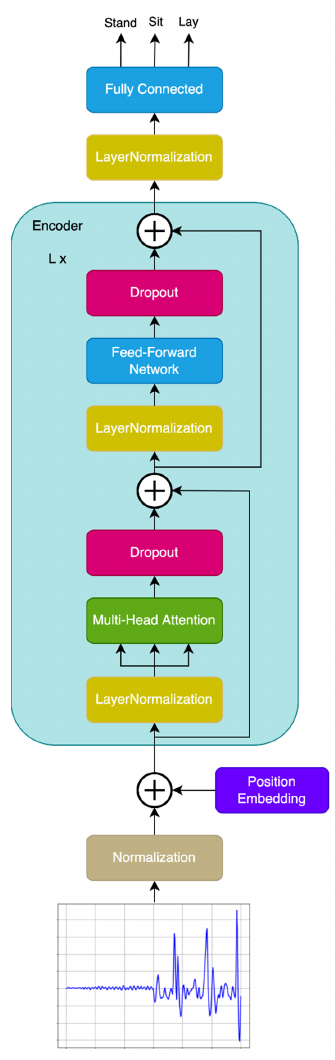
Figure 1. The transformer model for human activity recognition.